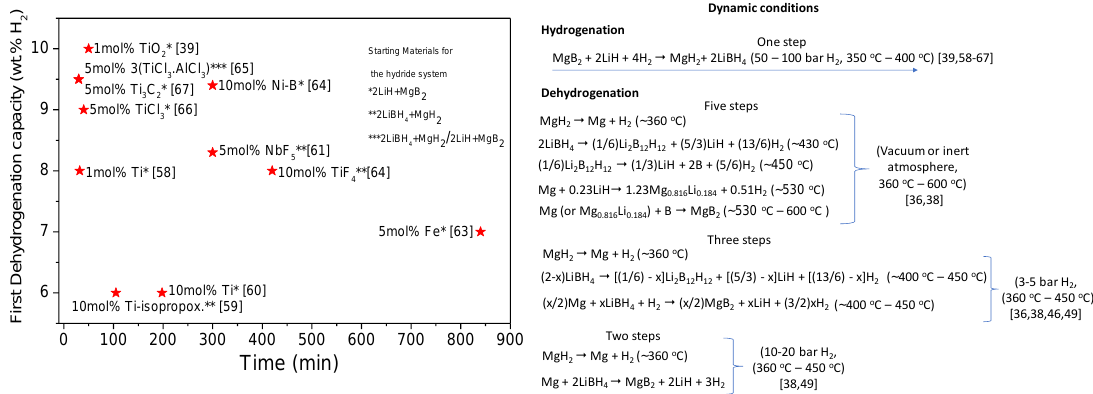
Figure 6. Kinetics of the 2LiBH 4 :MgH 2 hydride system: First dehydrogenation capacities after adding TM and TMC against time for the hydrogen release and reaction pathways under dynamic conditions. (cid:70) First dehydrogenation capacity. Starting material for the hydride system: * 2LiH + MgB